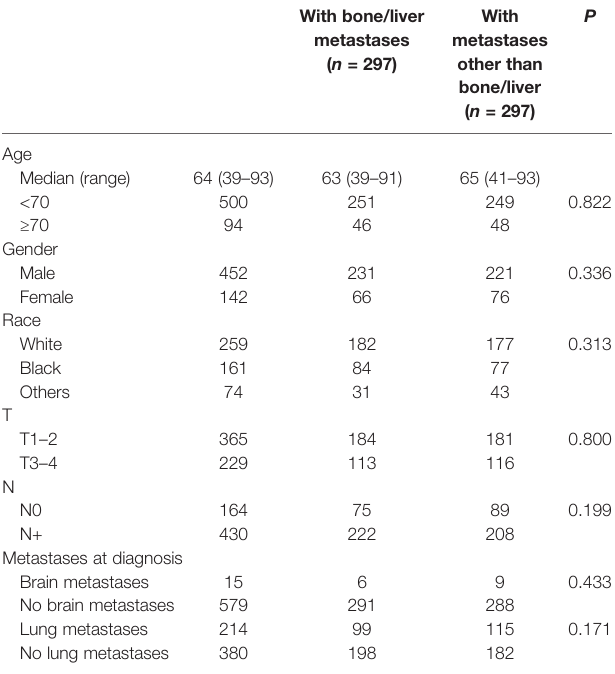
TABLE 4 | The clinical parameters of matched groups with different metastases. With bone/liver